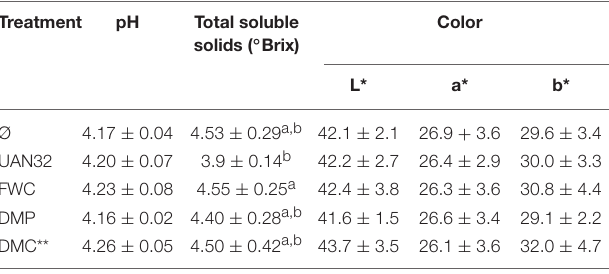
TABLE 4 | Red tomato quality measurements of pH ( N = 4), soluble solids ( N = 4), and color ( n = 10, N = 40).